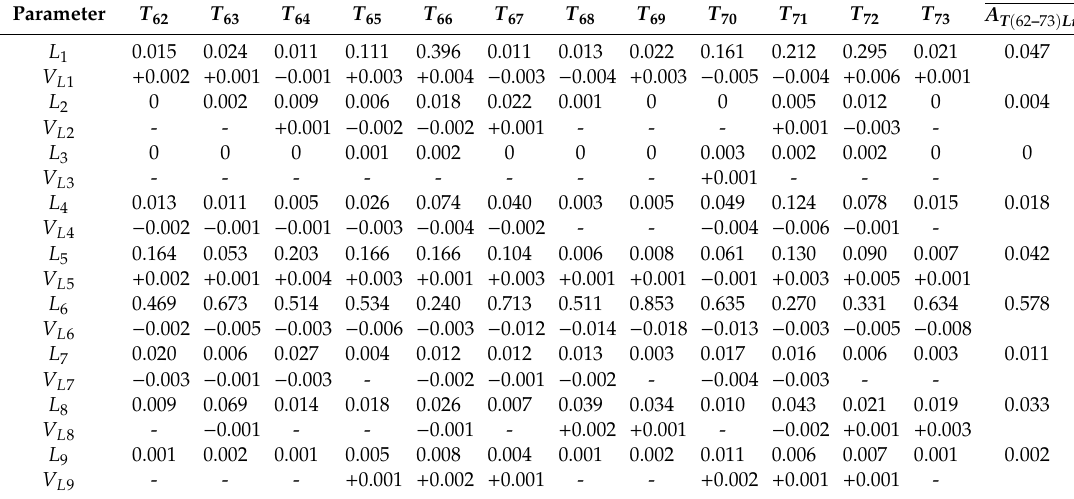
Table A15. Activity per land category in Russia, Siberian Federal District. Mean values for